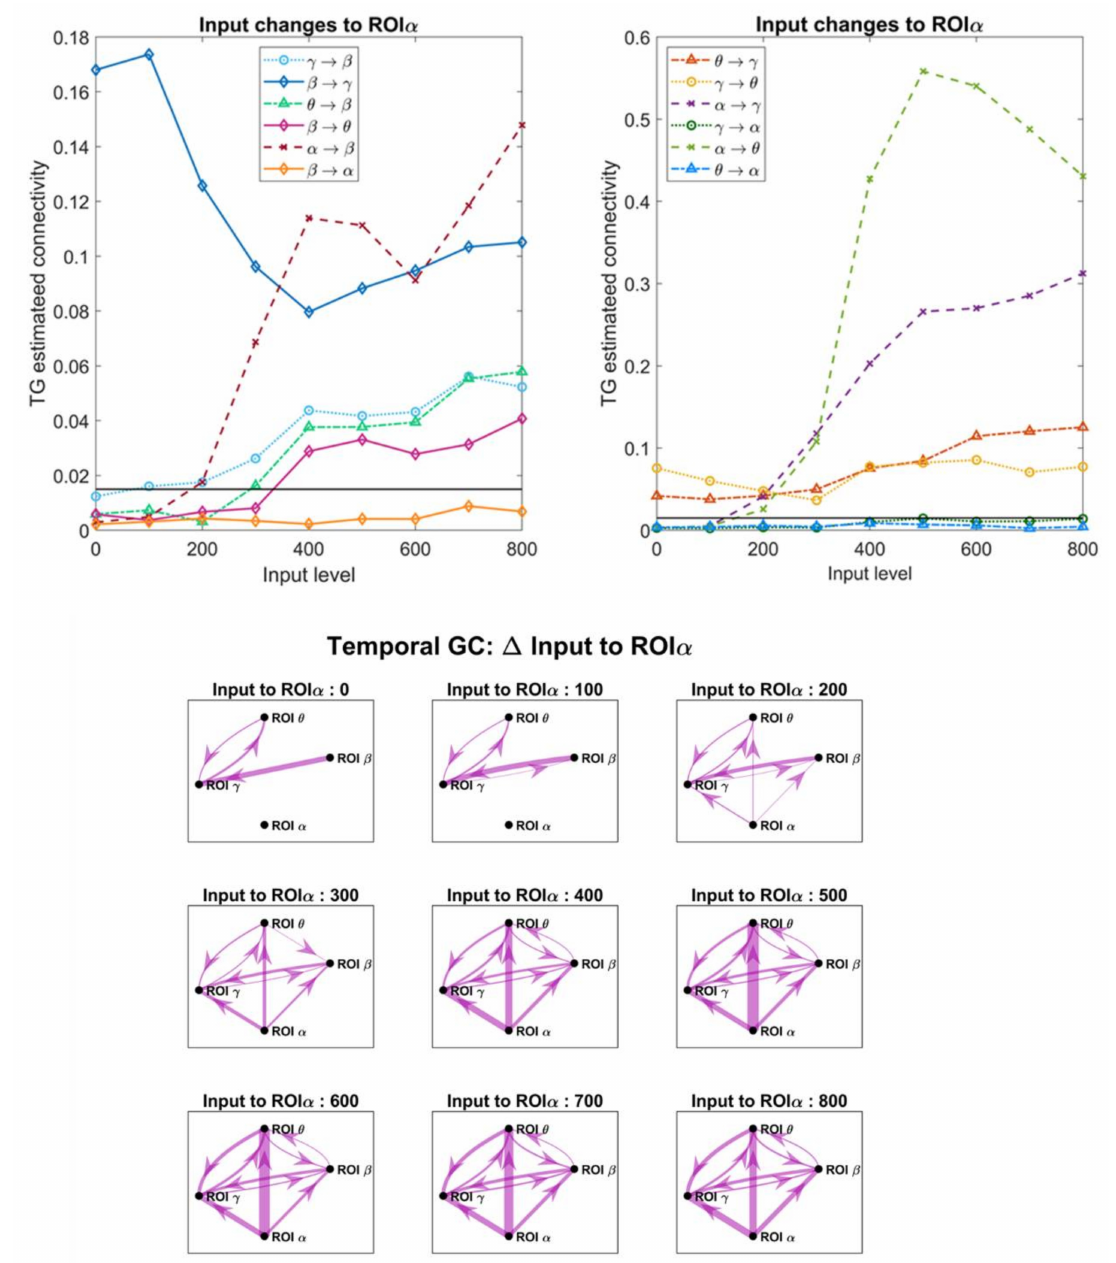
Figure 10. Upper panels: Values of connectivity among the ROIs estimated with the temporal Granger causality with reference to the network in Figure 2A, when the input to pyramidal neurons in ROI α was progressively varied from 0 to 800, as in the x -axis, and all other inputs and connections were maintained at the basal value, as in Figure 2A. It is worth noting that all estimated connections from ROI α to the other regions increase significantly. Many other connections increase too with the appearance of spurious terms. Bottom panels: connectivity graphs obtained from the estimates using a threshold as low as 0.015 (the threshold is depicted as a horizontal black line in the upper panels). The emergence of spurious connections is evident from these